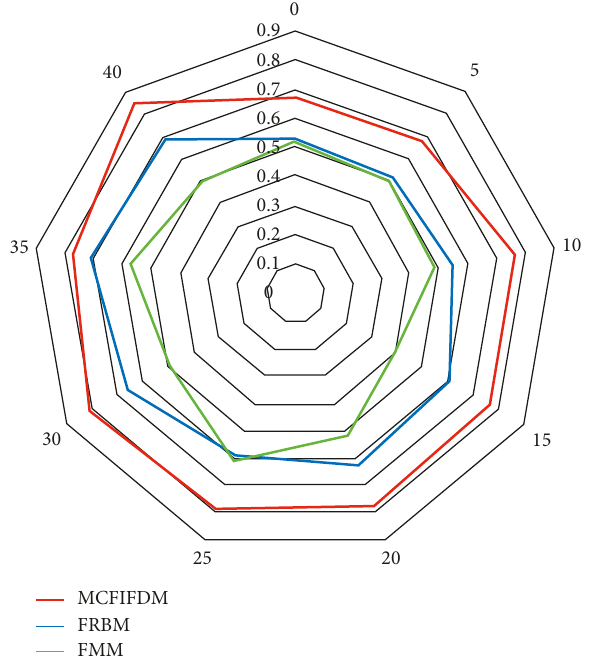
Figure 4: Comparison of different algorithms.